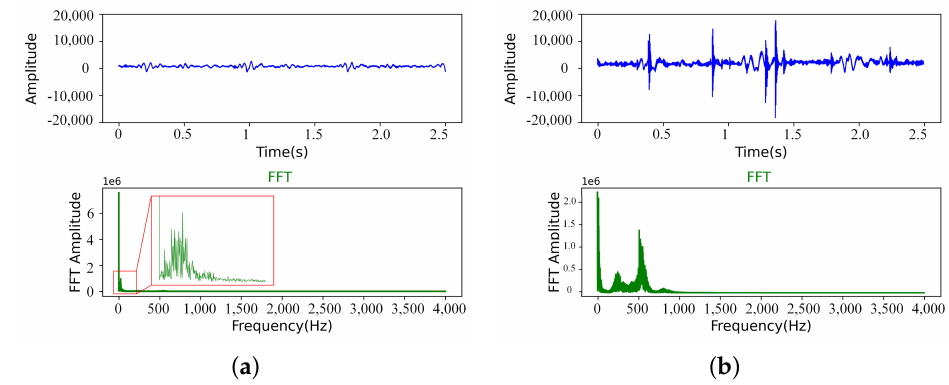
Figure 6. ( a ) Normal bowel sounds (After segmentation). ( b ) Bowel sounds before defecation (After